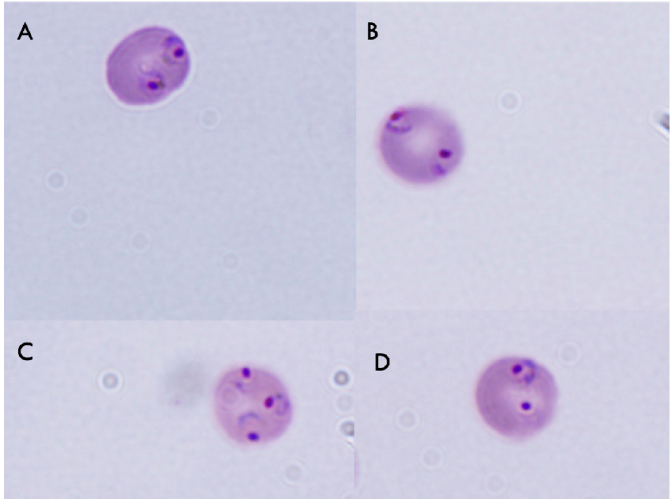
Figure 11. Morphology changes induced by treatment with PKC and phosphoinositide 3-kinase (PI3K) inhibitors. Erythrocytes infected with P. falciparum in the schizont stage were either incubated without (w/o inhibitor) or pre-incubated with ( A ) no inhibitor, ( B ) 3-methyladenine (3MA), ( C ) LY29400, and ( D ) bisindolylmaleimide I, and then treated with pumilacidins A and C at 10 µ M for 24 h. The parasite morphology was analyzed by Giemsa smear under light microscopy.